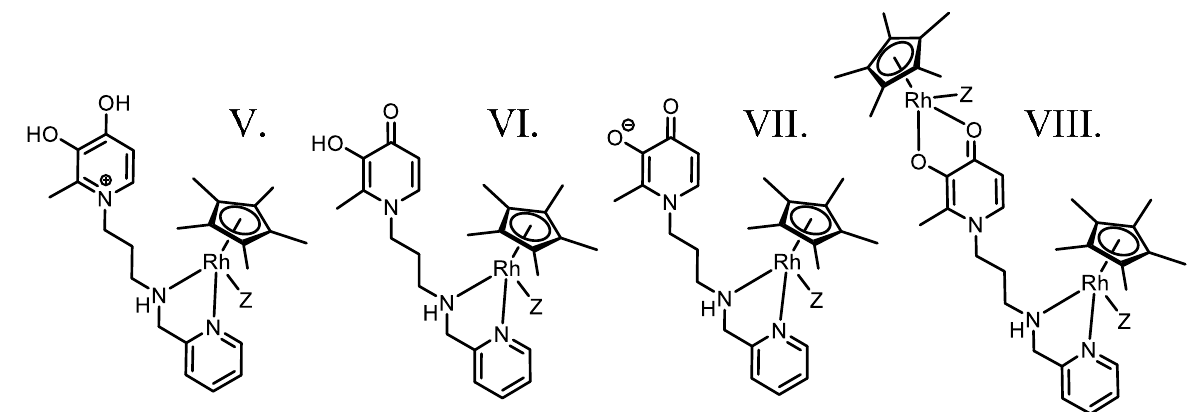
Figure 10. Suggested structures of the species in the [(η 5 -Cp*)Rh] 2+ –L5 system (Z = Cl – /H 2 O), charges of the metal ions are omitted for clarity. ( V ) [MH 2 L] 3+ ( • ); ( VI ) [MHL] 2+ (o); ( VII ) [ML] + ( ▪ ); ( VIII ) [M 2 L] 3+ (Δ); symbols represent the notation of the species in the NMR figures.